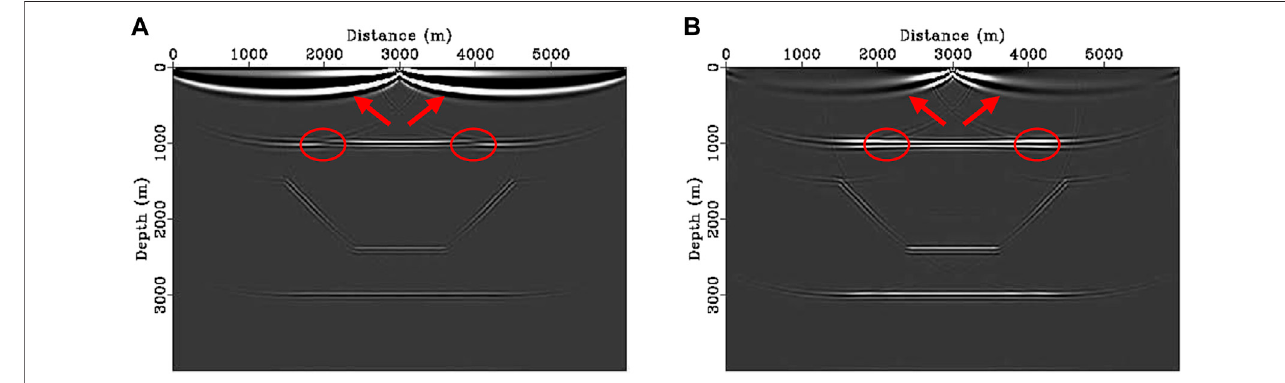
FIGURE 4 | PP images by the scalar imaging condition with a Laplace fi lter (A) and with a pseudo-Laplace fi lter (B) . Compared with the PP image with a Laplace fi lter(PanelA),backscatteringnoisesuppression(markedbyredarrows)and polarityreversalcorrection(marked byred circles)havebeen showninthePPimage witha pseudo-Laplace fi lter (Panel